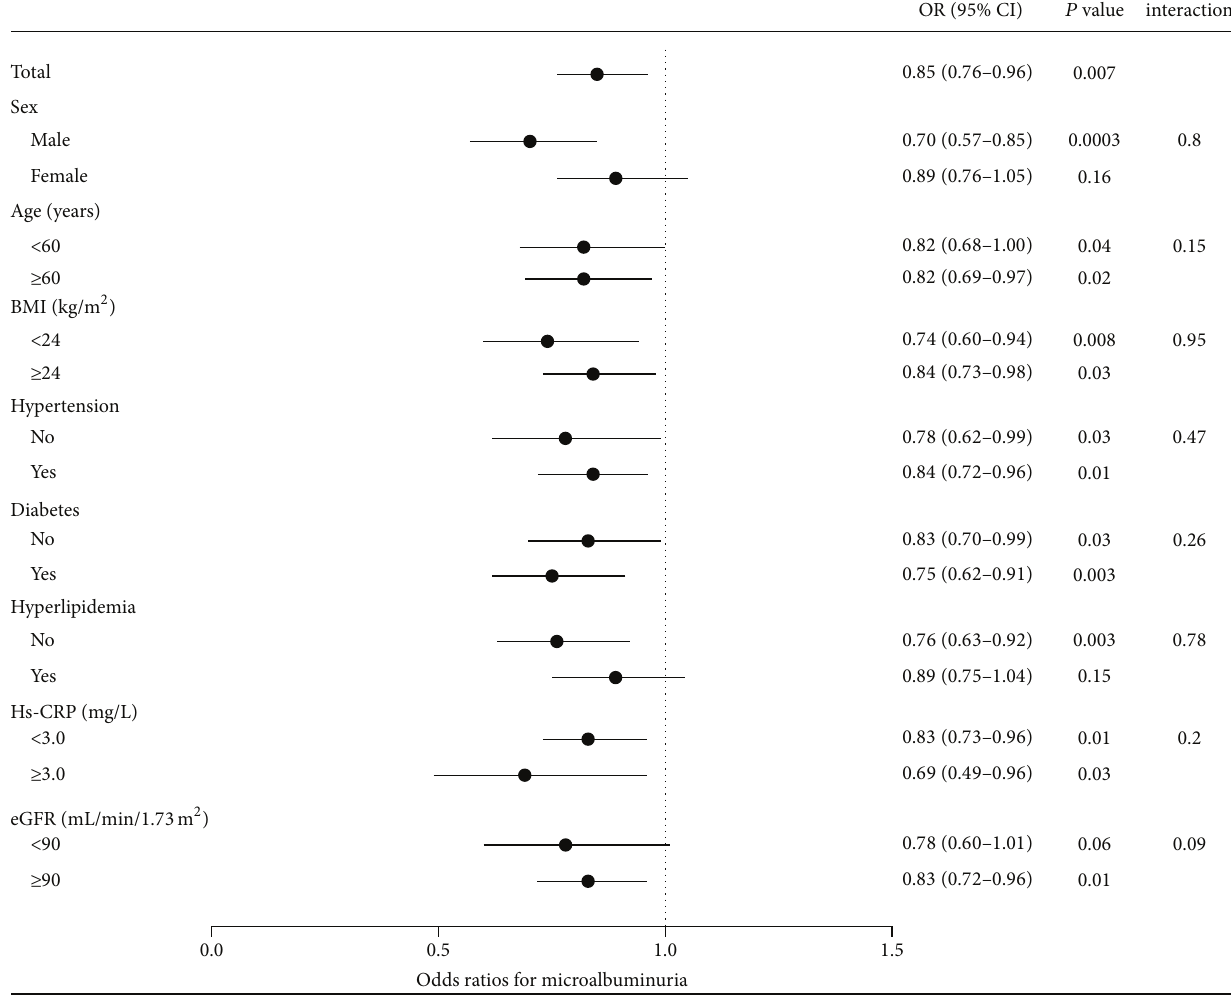
Figure 2: Adjusted odds ratios (OR) for each 1 s.d. increase in log FT3 concentration associated with the risk of microalbuminuria. Logistic regression model was adjusted for potential confounding factors including age, sex, BMI, smoking and drinking status, SBP and DBP, TC, triglycerides, FPG and OGTT-2h PG, TPOAb and TgAb, hs-CRP, use of ACEI/ARB drugs, and eGFR (except for the strata variables). CI, confidence